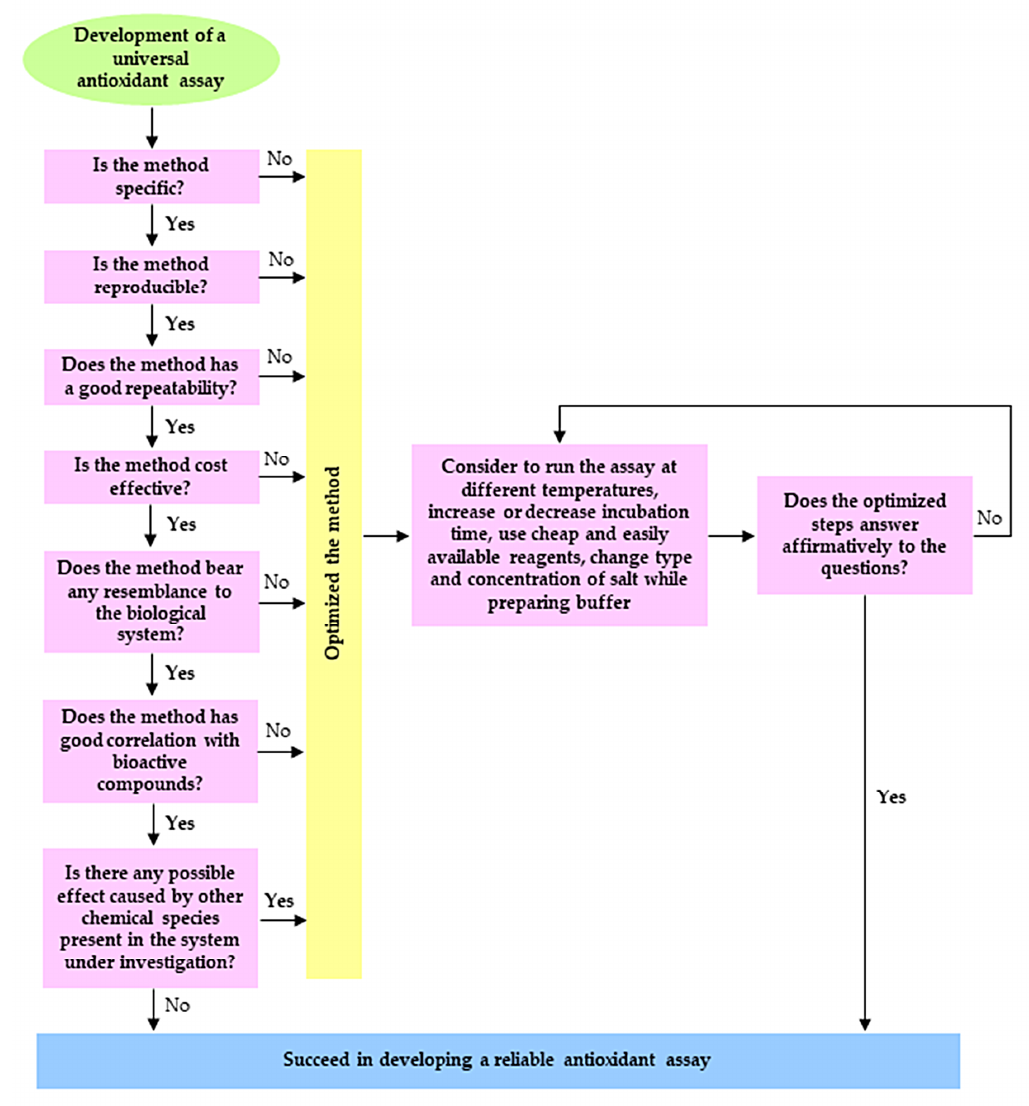
Figure 19. Flowchart with proposed steps to follow in order to develop a universal antioxidant